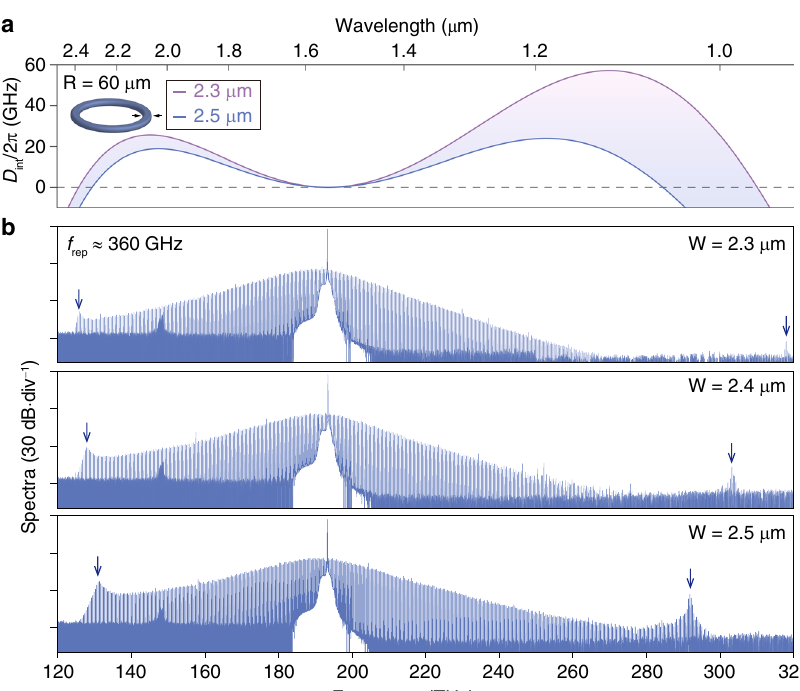
Fig. 3 Octave soliton microcombs with agilely tunable spectra. a Engineered integrated dispersion ( D int ) curves of 60 μ m-radius (R) AlN resonators at varied widths of 2.3 – 2.5 μ m revealed by the colored shadow regime. b Corresponding soliton microcomb spectra at resonator widths of 2.3, 2.4, and 2.5 μ m from the top to bottom panel, respectively. The repetition rate ( f rep ) is ~360 GHz, while the vertical arrows in spectral wings indicate the emergence of DWs. Akin to Fig. 2a, high-frequency DWs here also exhibit an evident blue shift from the D int = 0 position. From a sech 2 fi t, the corresponding temporal pulse duration is estimated to be ~23, 22, and 19 fs (from top to bottom), respectively.